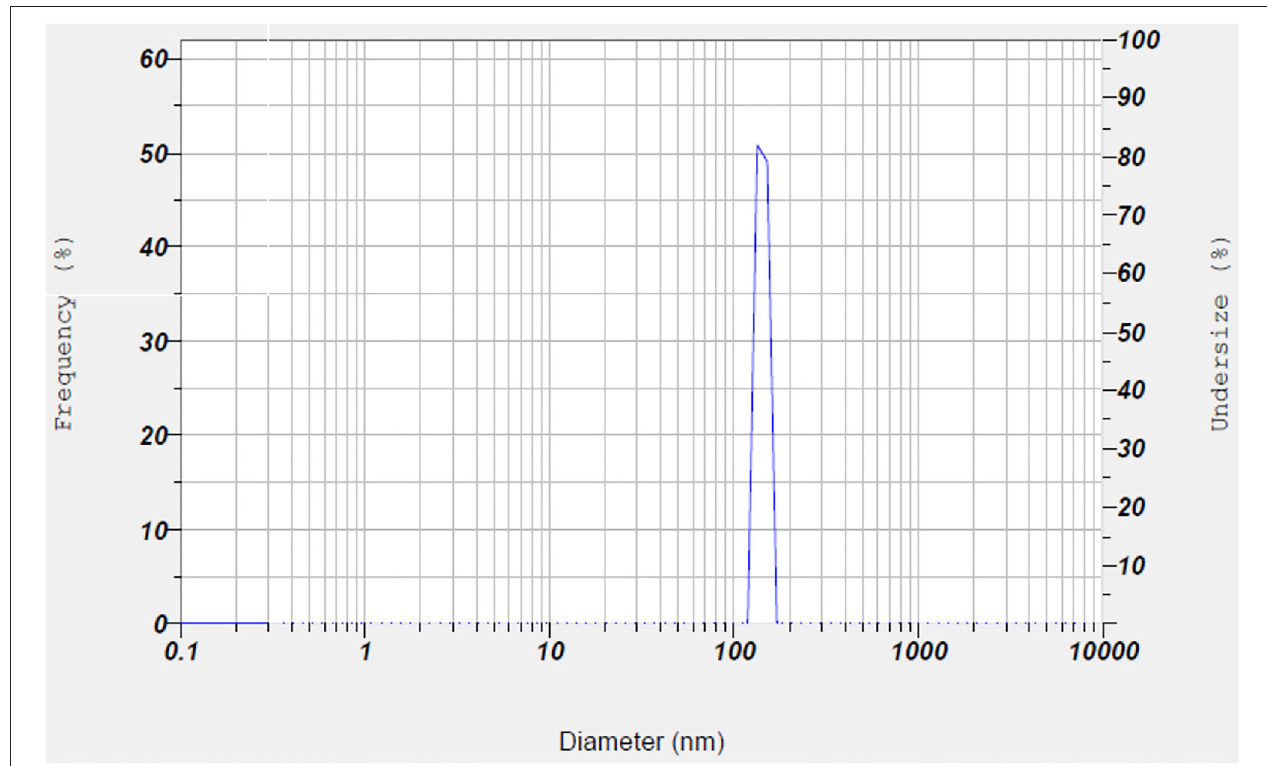
FIGURE 2 | Particle size distribution of chitosan/folic acid